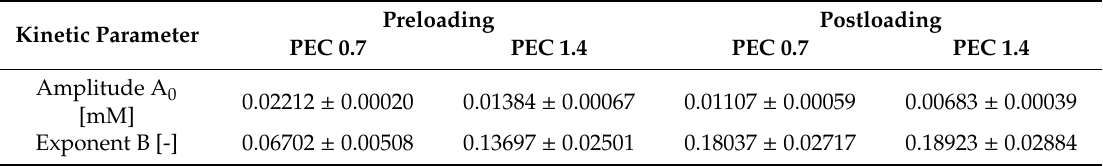
Table 1. Kinetic parameters A 0 and B of BZM loading at PDOPAC / PEC NP at c BZM = 0.25 mM. Kinetic Parameter